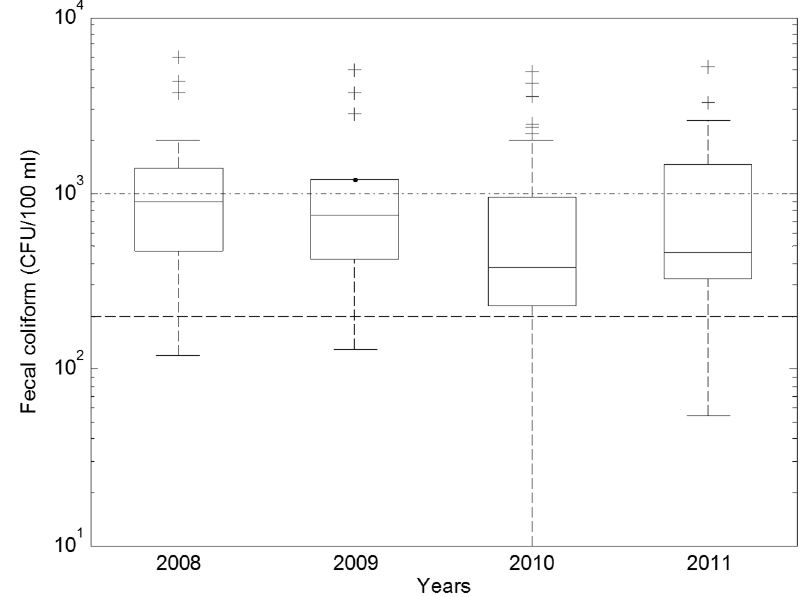
Figure 3. Boxplots of fecal coliforms (FC) concentrations for summer 2008 to 2011. The dashed line represents the 200 CFU/100 mL water quality standard and the line composed of mixed dashes and dots represents the 1000 CFU/100 mL